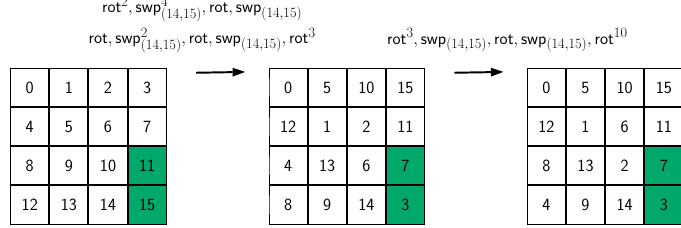
Figure 7: Performing σ with swp then seq3 ◦ seq2 ◦ seq1 = τ M